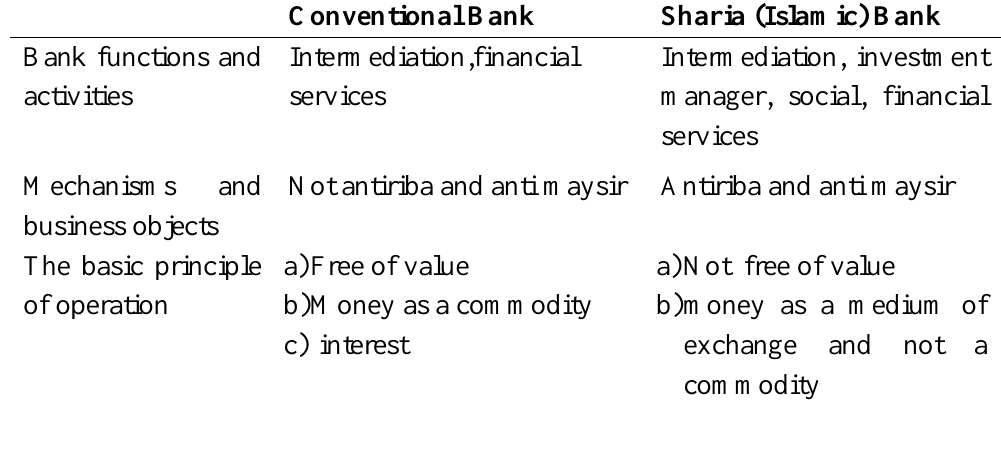
Tabel 1. Difference between Conventional Bank and Sharia (Islamic)